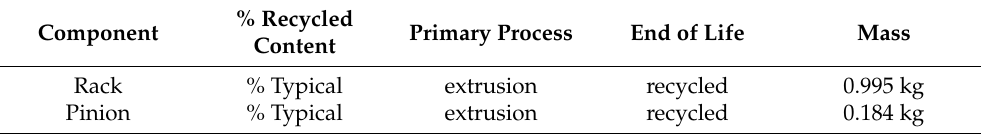
Table 1. LCA evaluation parameters